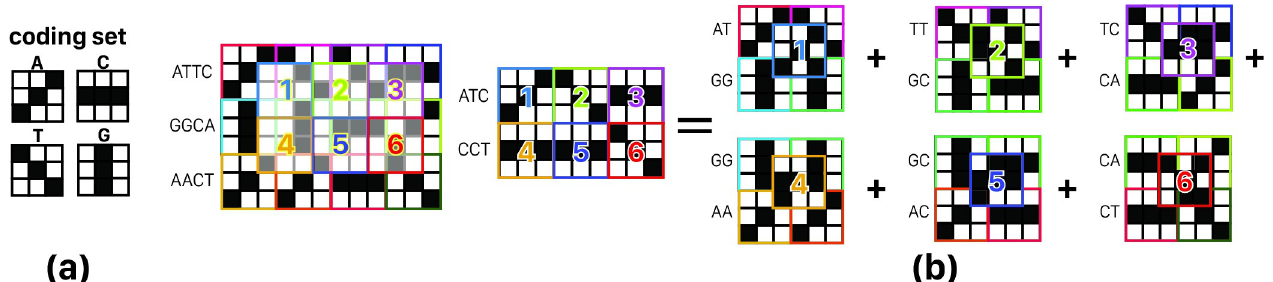
Fig 5. a) Example of coding set, b) problem 1 with i = 3, j = 2, and K = 3 for one step of cross-correlation; if in the left side, the sum of inner product of two grids for the shown spatial relative place of them will be calculated, its result (= 5) was equal to the sum of inner product of right side elements (right side elements are sub-grid of left side grids (= 5).